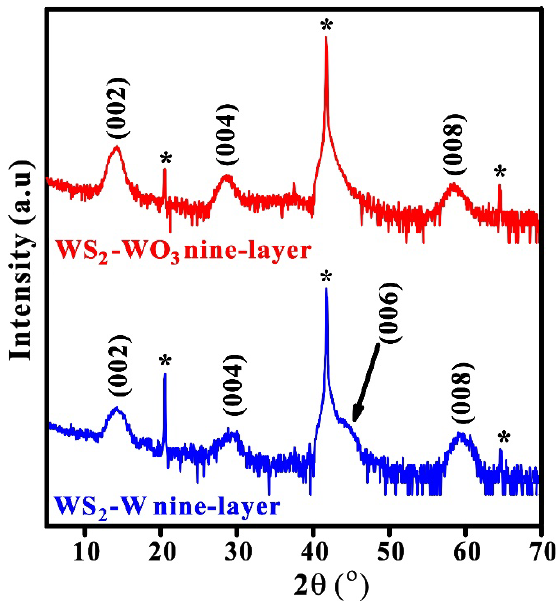
Figure 5. XRD of nine - layer WS 2 sulfurized from W and WO 3 at 900 °C It shows narrower FWHMs of 002, 004, and 008 signals from WS 2 - WO 3 (2.1 ± 0.1; 3.4 ± 0.2; 2.6 ± 0.2, respectively) then from WS 2 - W (2.2 ± 0.1; 4.1 ± 0.2; 3.1 ± 0.2, respectively) .